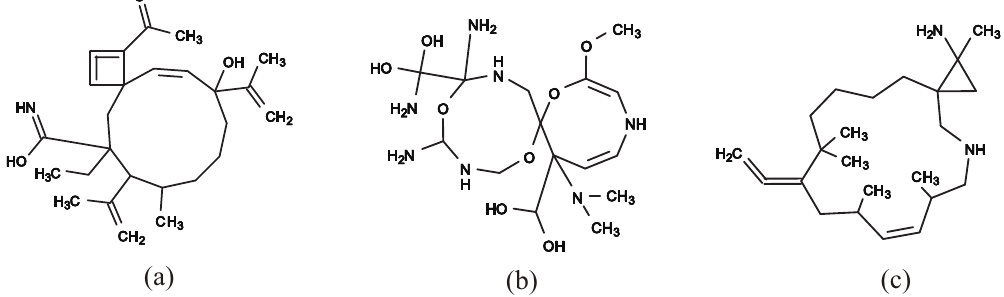
= 5, θ = 0, n = 30, core size Figure 11. An illustration of inferred rank-2 chemical graphs G ∗ : ( a ) y ∗ Kow = 250, θ = 0, n = 30, core size = 16, core height = 2, d max = 4; = 14, core height = 2, d max = 3; ( b ) y ∗ Mp = 150, θ = 0, n = 25, core size = 17, core height = 2, d max = 3. ( c ) y ∗ Bp